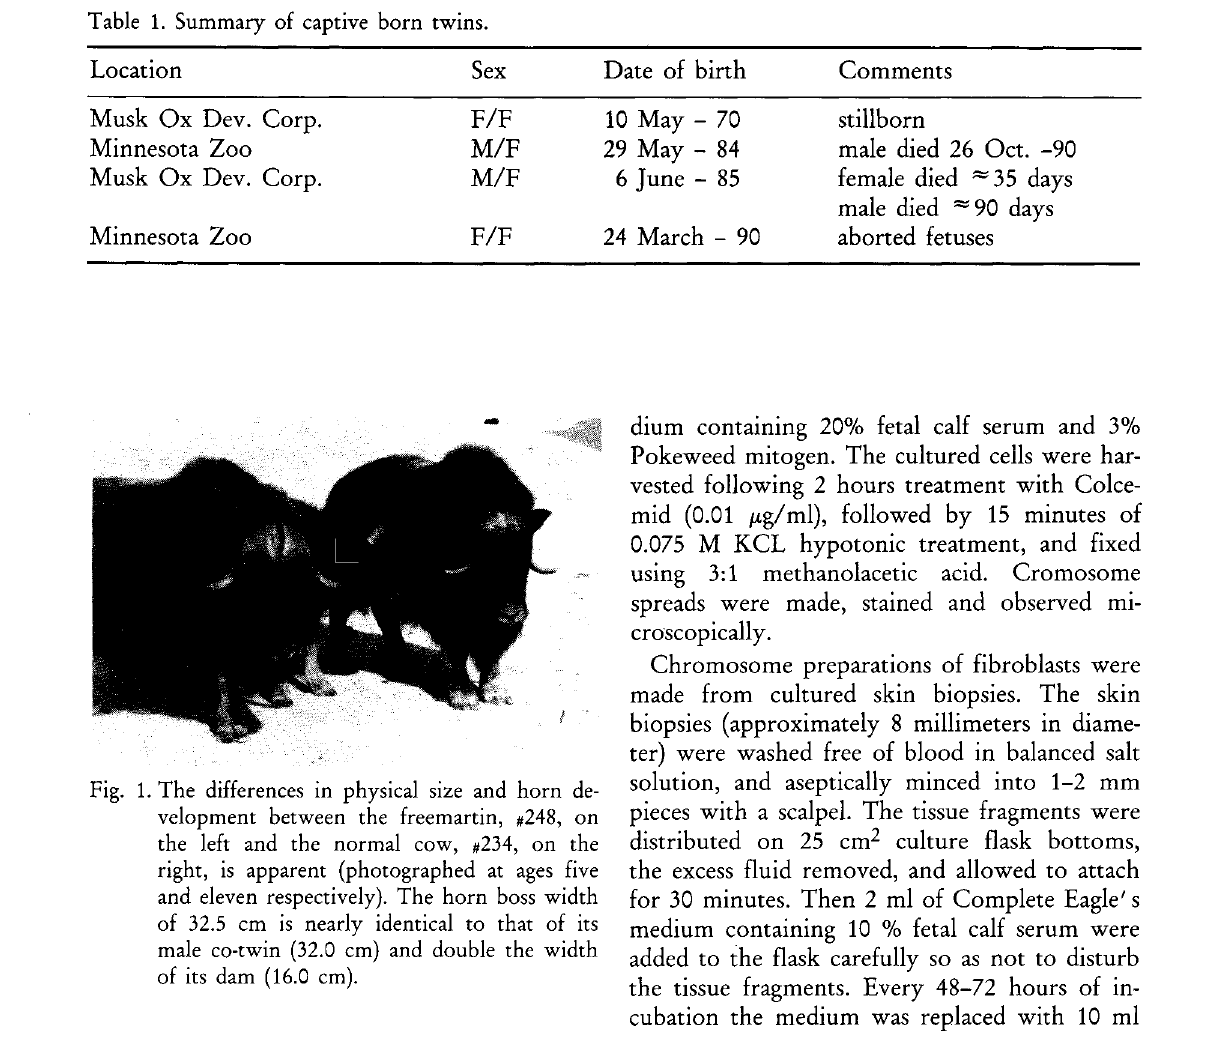
Fig. 2. The external genitalia of the freemartin, #248, with the vulval lips parted to reveal the enlar ged